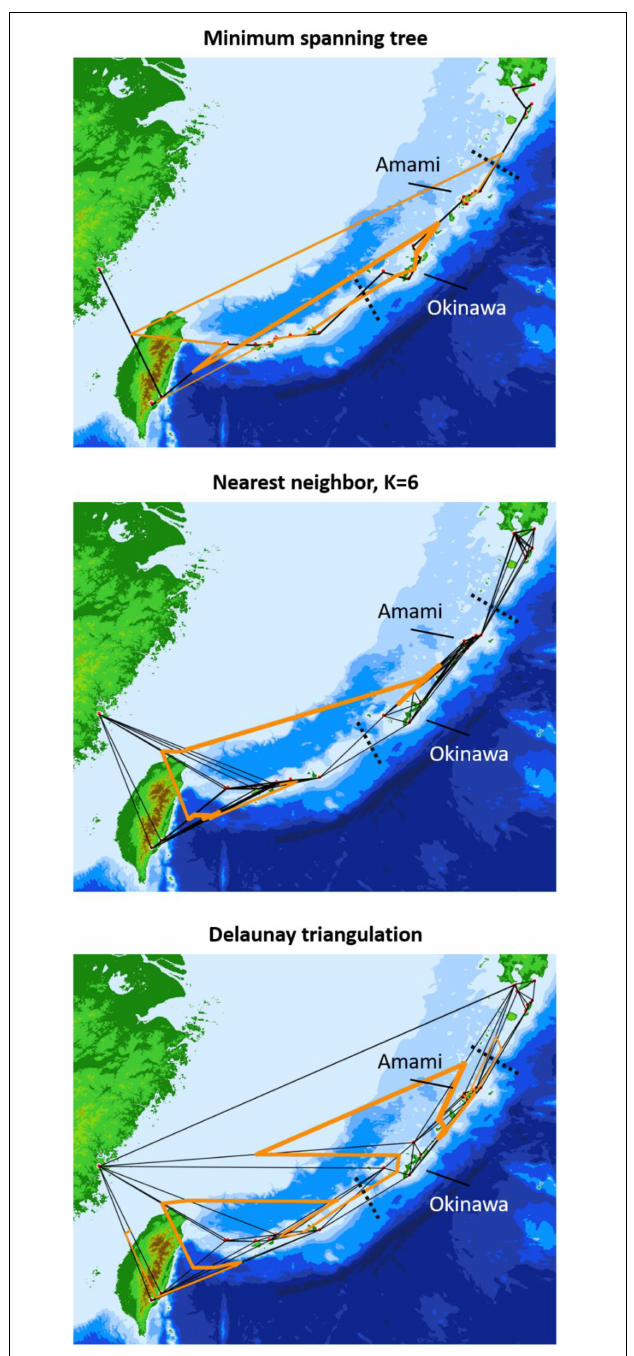
FIGURE 7 | Population genetic boundaries based on three connection networks. The solid black and orange lines represent the connection network and barriers, respectively, and the dashed black lines are the geological boundaries separating the northern, central, and southern Ryukyus.